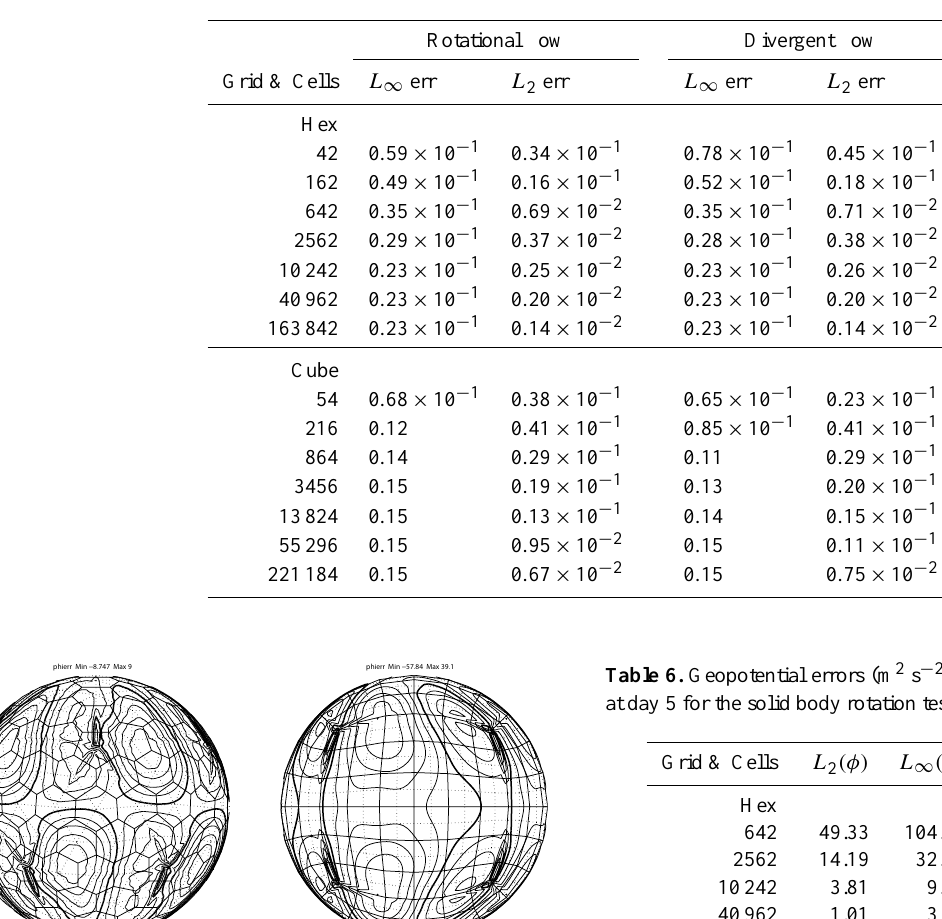
Table 5. Convergence of W operator used to construct the Coriolis terms.